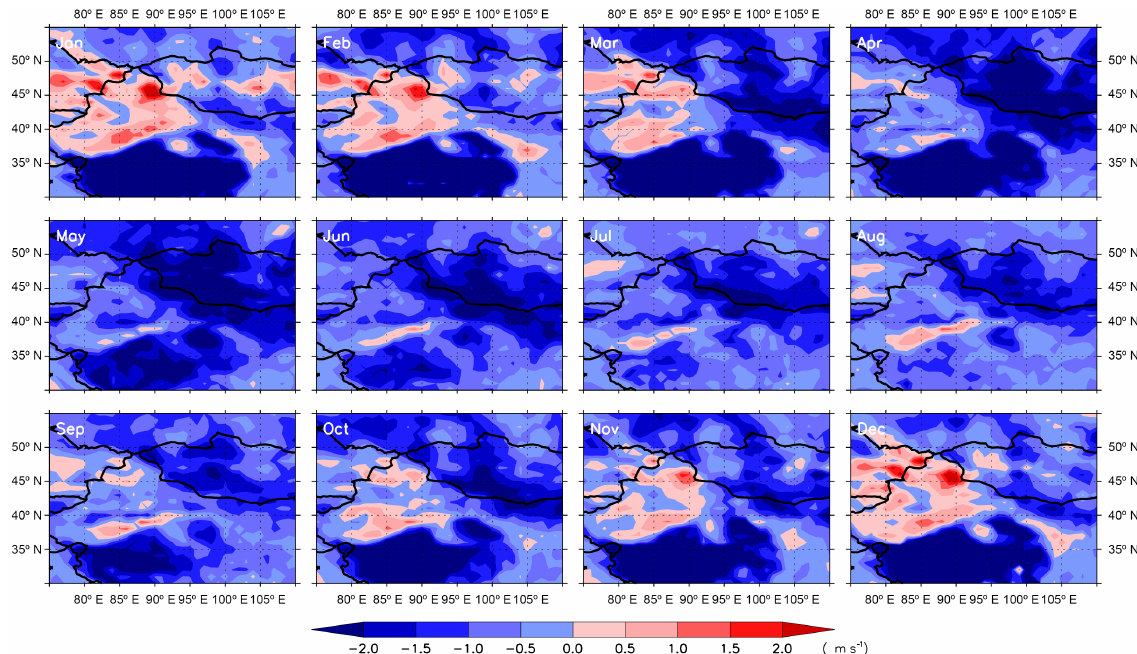
Figure 8. Annual cycle of the near-surface wind speed difference at 06:00UTC between NLLJ and non-NLLJ